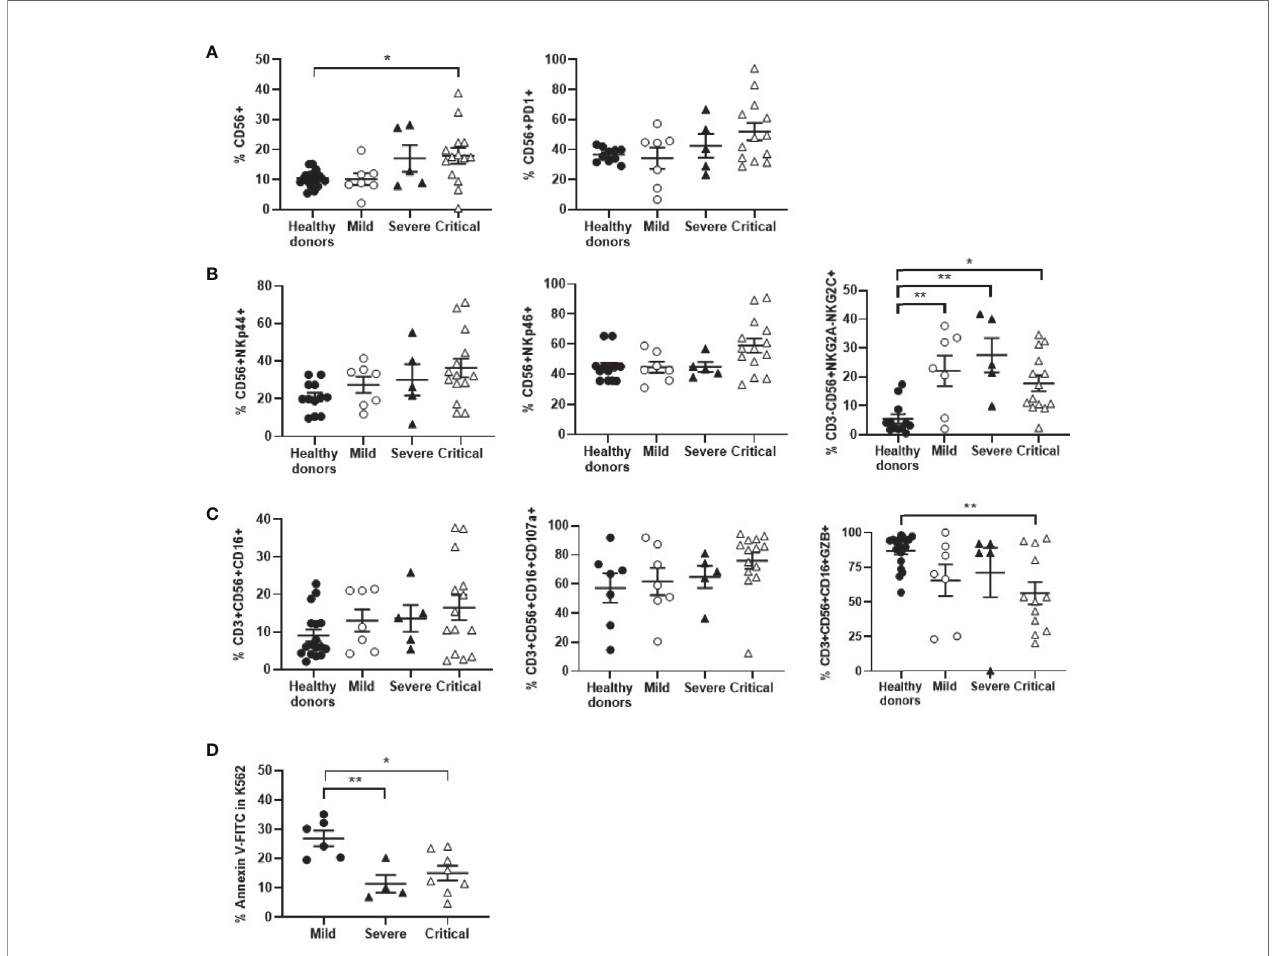
FIGURE 4 | Analysis of NK and NKT cells in patients with different presentations of COVID-19. Analysis of NK cells expressing the activation marker CD56 and the immune exhaustion marker PD1 (A) , as well as other activation markers (B) . (C) Analysis of NKT cell population CD3+CD56+CD16+, as well as the degranulation marker CD107a and their ability to synthesize GZB in response to Hsp70 peptide. (D) Cytotoxicity of PBMCs from patients with different presentations of COVID-19 was analyzed by quantifying early apoptosis in K562 cells as unspeci fi c target after co-culture (1:10) for 1 hour. Each dot corresponds to one sample and lines represent mean ± SEM. Statistical signi fi cance was calculated using one-way ANOVA and Tukey ’ s multiple comparisons test. *p < 0.05; **p <